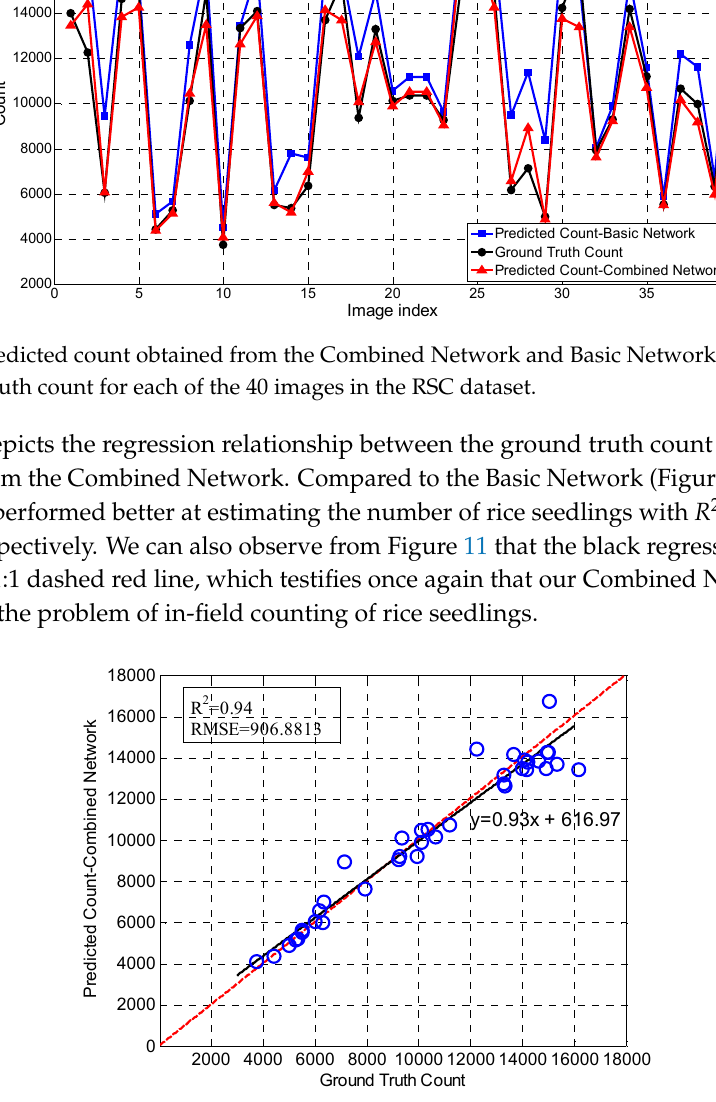
Figure 11. Manual counting versus automatic counting with our Combined Network model. The 1:1 line is dashed red. R 2 and RMSE represent the coefficient of determination and the root mean square